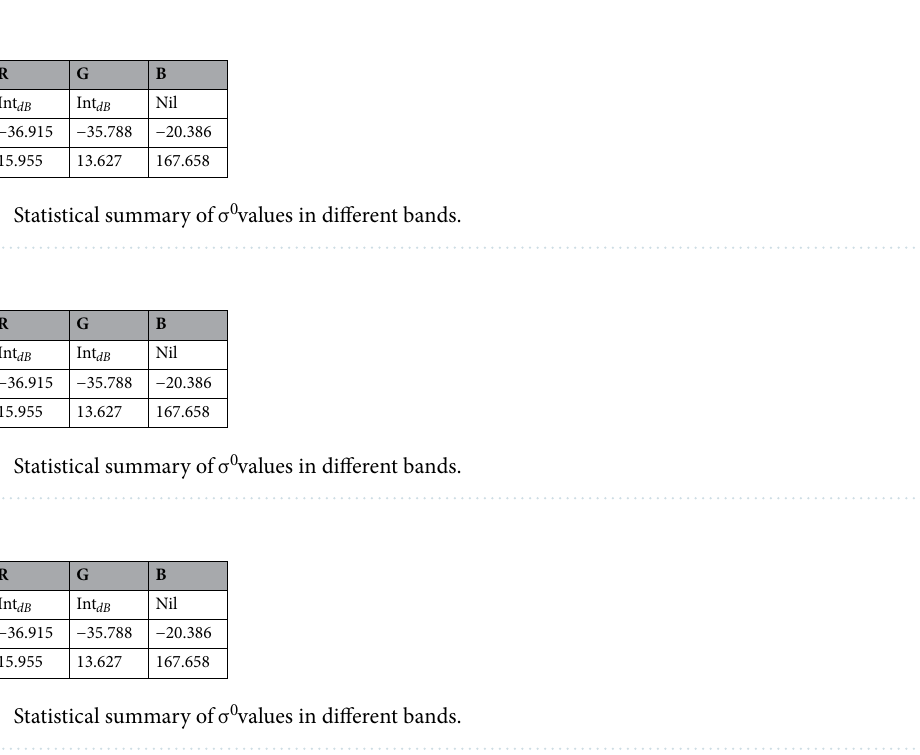
Table 6. Statistical summary of σ